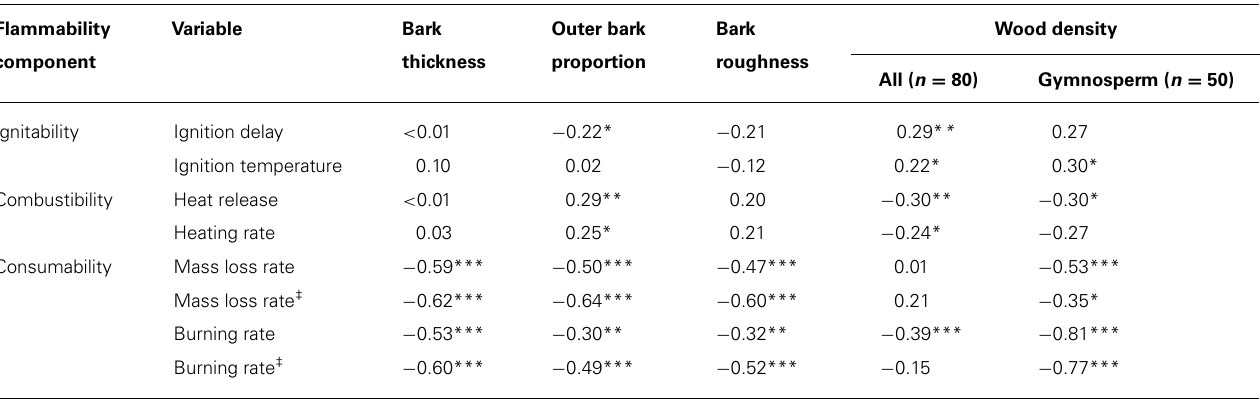
Table 2 | Spearman correlation coefficients between the flammability parameters and the biological